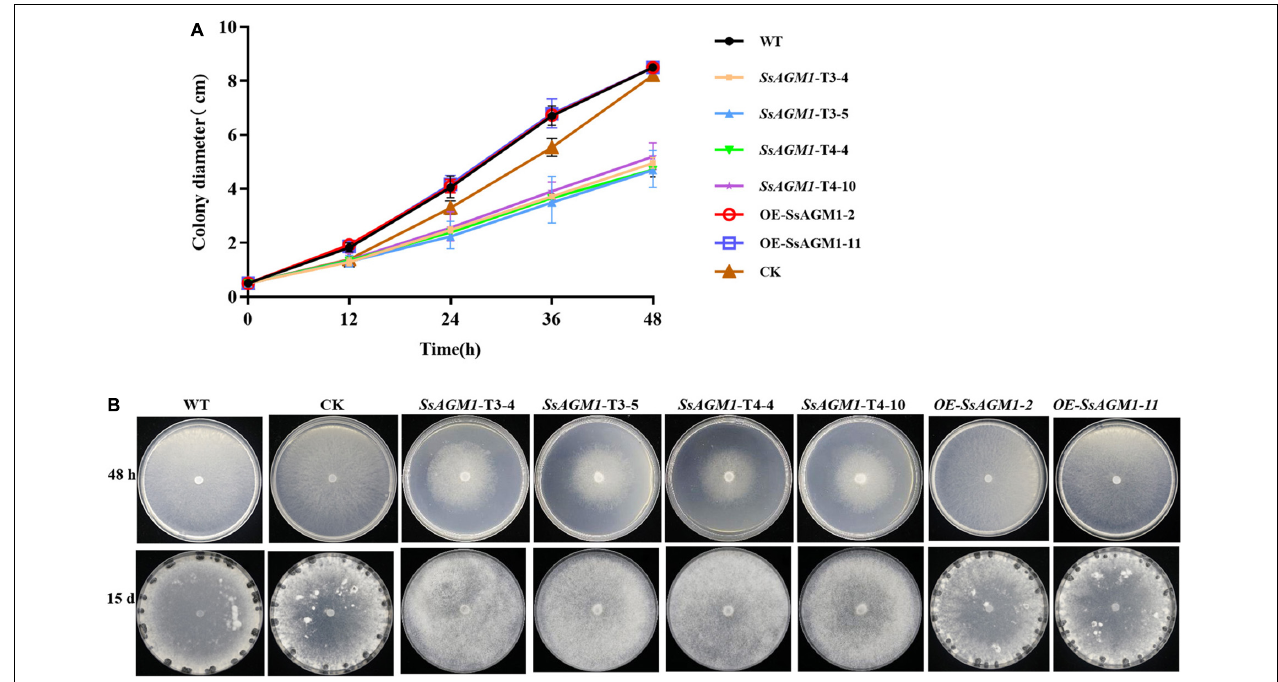
FIGURE 6 | SsAGM1 is involved in vegetative growth and sclerotia formation in Sclerotinia sclerotiorum . (A) The hyphae growth rate in wild-type strain, control strain, gene-silenced transformants, and overexpression transformants. Error bars indicate the standard deviation of three replicates. (B) Sclerotial formation and colony morphology among wild-type strain, control strain, gene-silenced transformants, and overexpression transformants at 24 h or 15 days after inoculation. WT, Wild-type strain; CK, the control strain.